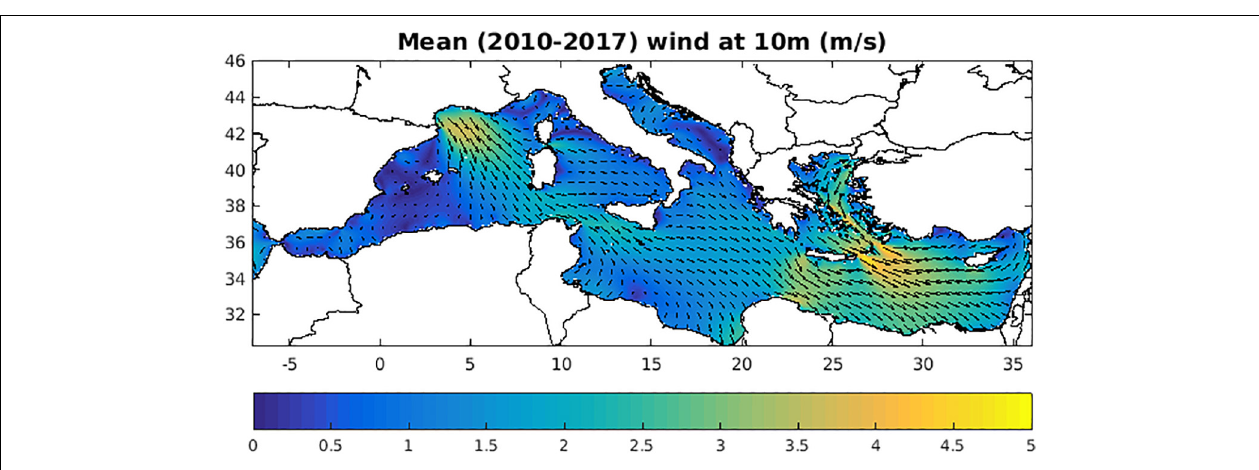
FIGURE 8 | Mean (2010–2017) wind at 10 m (m/s), obtained from POSEIDON operational atmospheric